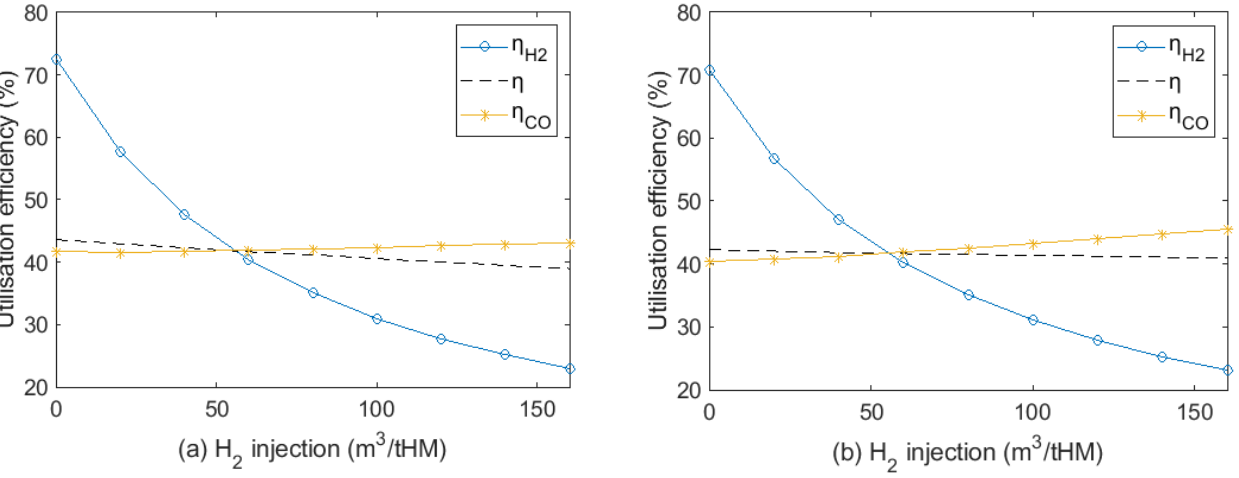
Figure 8. Variations of ( a ) bosh gas and ( b ) top gas composition with hydrogen injection. (H 2 injec- tion at 0 m 3 /tHM indicates the operating condition of a traditional BF with oxygen enrichment rate at 9%.).